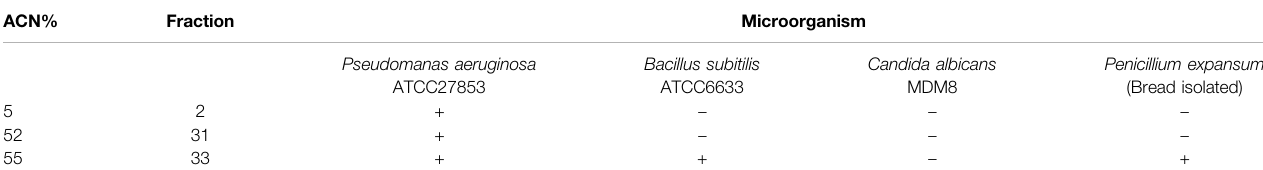
TABLE 1 | Antimicrobial activity fractions from Duvernoy ’ s gland secretion.